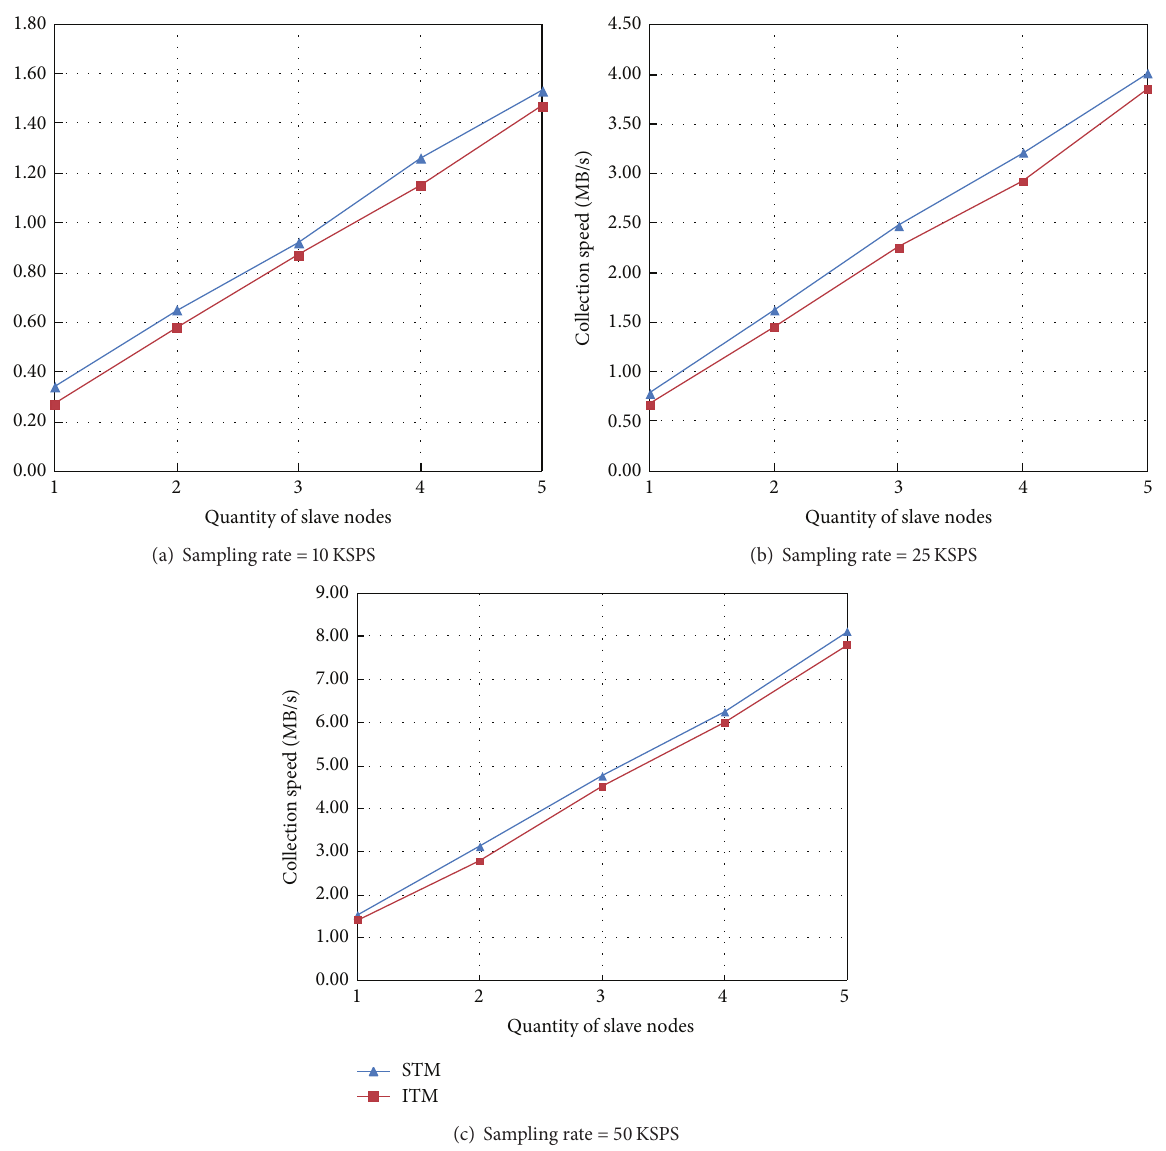
Figure 7: The relationship between acquisition speed and the number of slave nodes at different node sampling